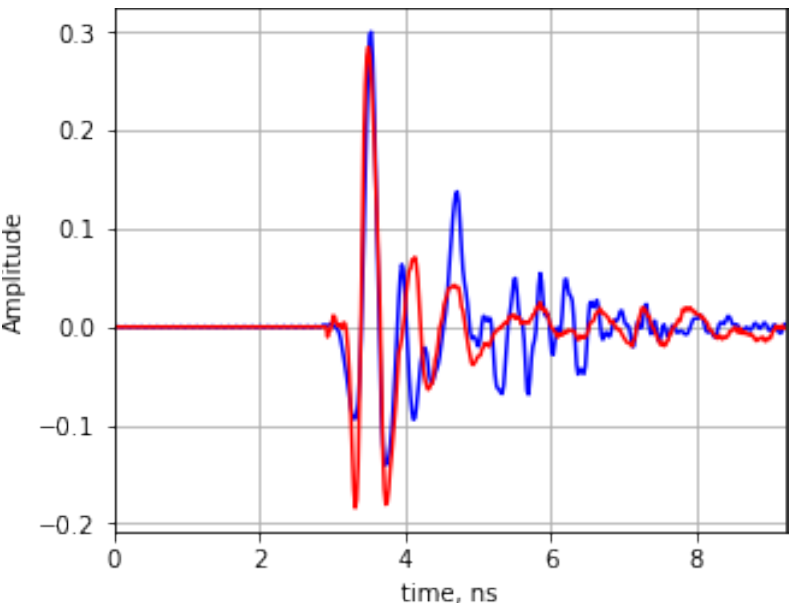
Figure 7. The simulated (blue) and measured (red) radar signals (shifted due to measurement offset) from a cement brick of thickness 95 mm at a distance 500 mm (correlation 79%).